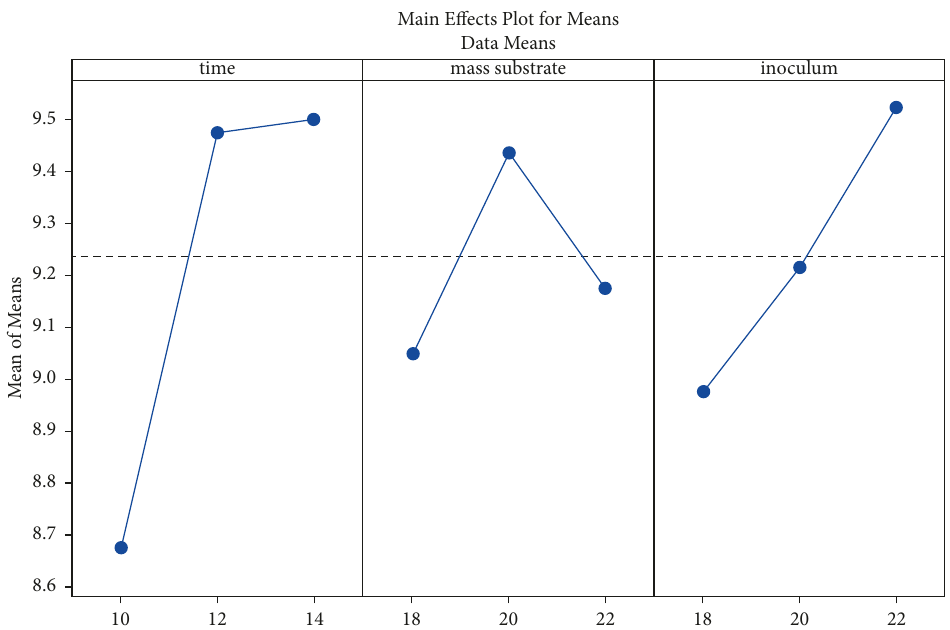
Figure 3: The main effects for means of time, mass substrate, and inoculum. Table 1: Analysis of variance for signal-to-noise (SN)